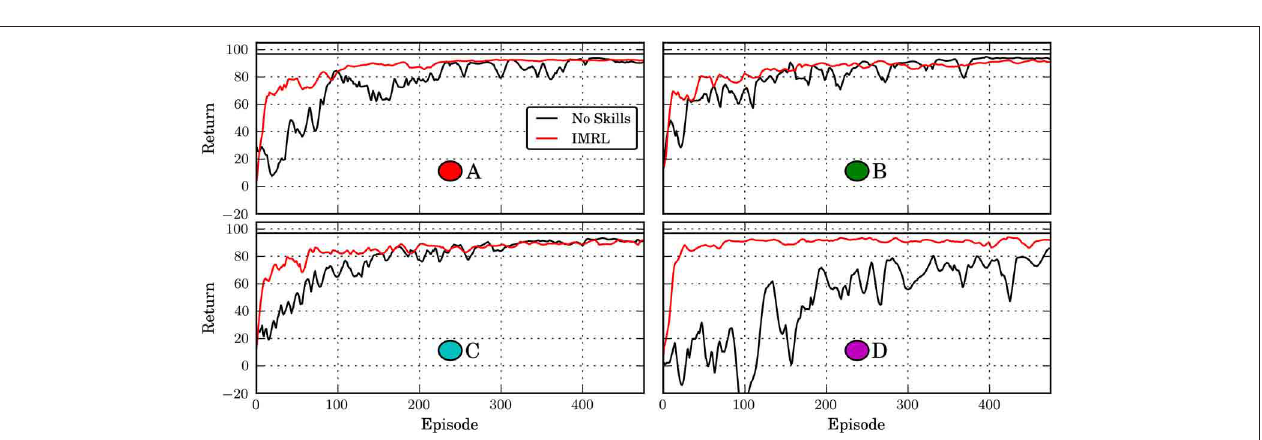
has no developmental period. The horizontal black line shows the average cost of the policy learned by the monolithic agent after 2500 episodes. All curves show median performance over 5 independent runs and have been smoothened by a moving window average with window length